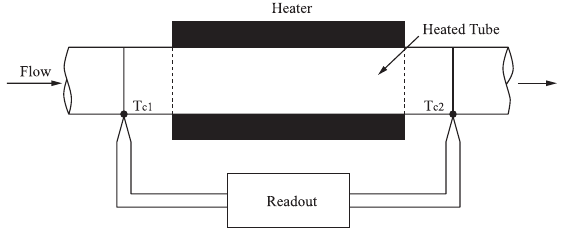
Fig. 1 A thermal mass flow meter (Yan,